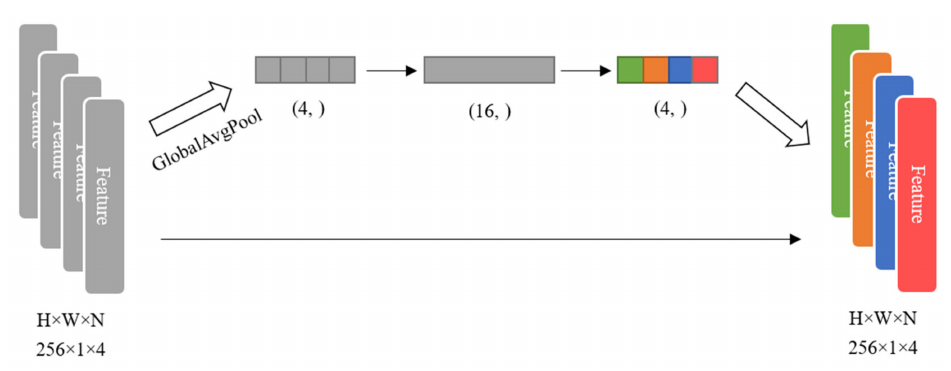
Figure 9. Structure of SE-like adaptive feature fusion